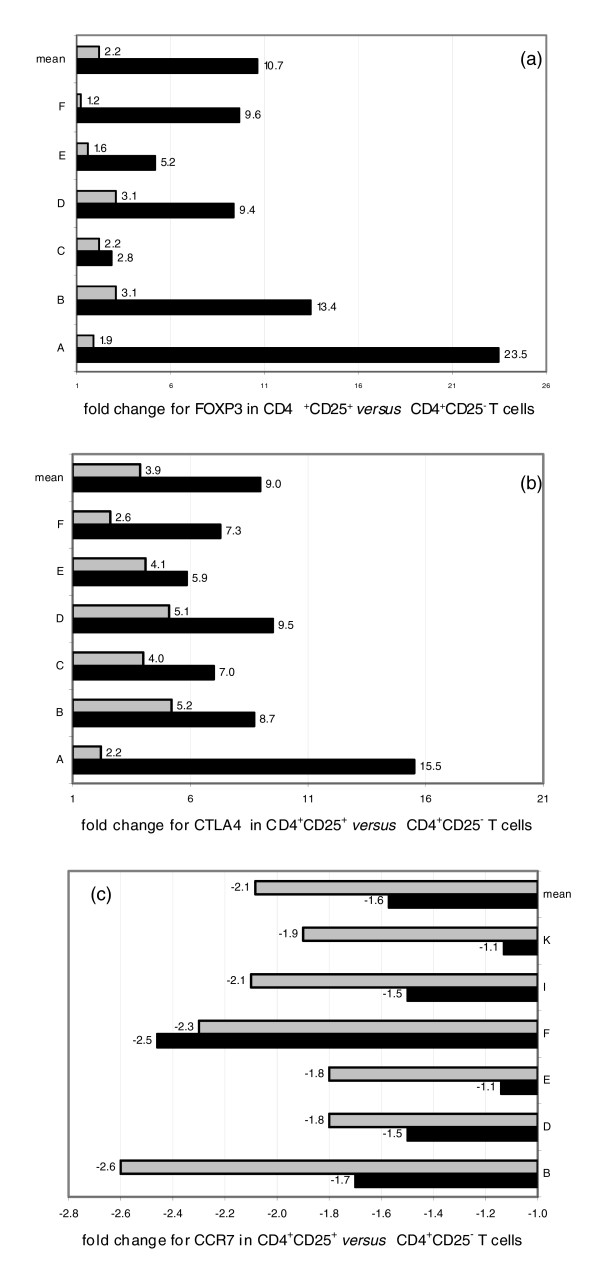
Old friends: confirmation of microarray results. Real-time RT-PCR was performed for (a) FOXP3, (b) CTLA4, (c) CCR7, and RPS9 (data not shown) expression in MACS separated human CD4+CD25+ TReg and CD4+CD25- naïve T cells. Following normalization to RPS9, relative mRNA amounts in CD4+CD25+ TReg cells were adjusted to corresponding expression levels in CD4+CD25- naïve T cells and expressed as fold changes. Real-time RT-PCR results, indicated by black bars, were compared with fold changes arising from the Human TReg Chip (represented by grey bars). The healthy donors, randomly chosen, are specified by letters (see Table 1). RT-PCR, reverse transcription polymerase chain reaction.